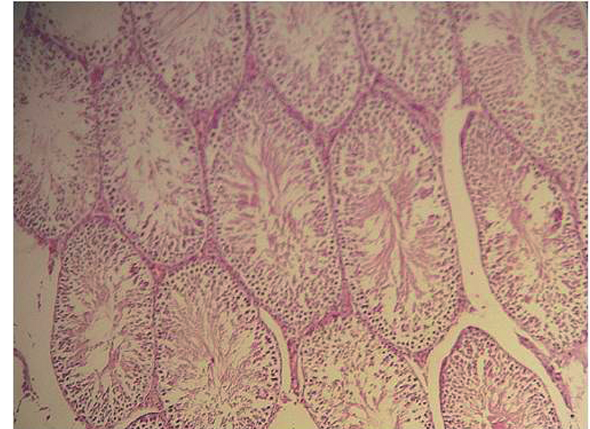
Figure 1 - Light microscopic view of testis tissues from IR group showing coagulative necrosis with loss of seminiferous tubule epithelium, edema and sloughed germinal cells. H&E staining; magnification of 10 × 10.